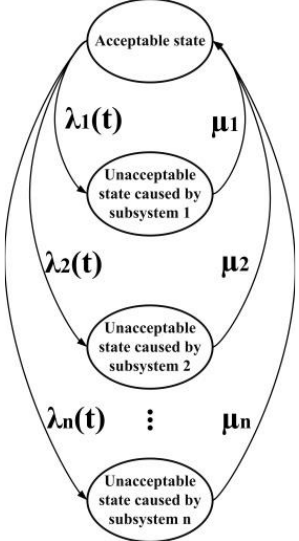
Figure 2. State transition diagram of CNC Machine